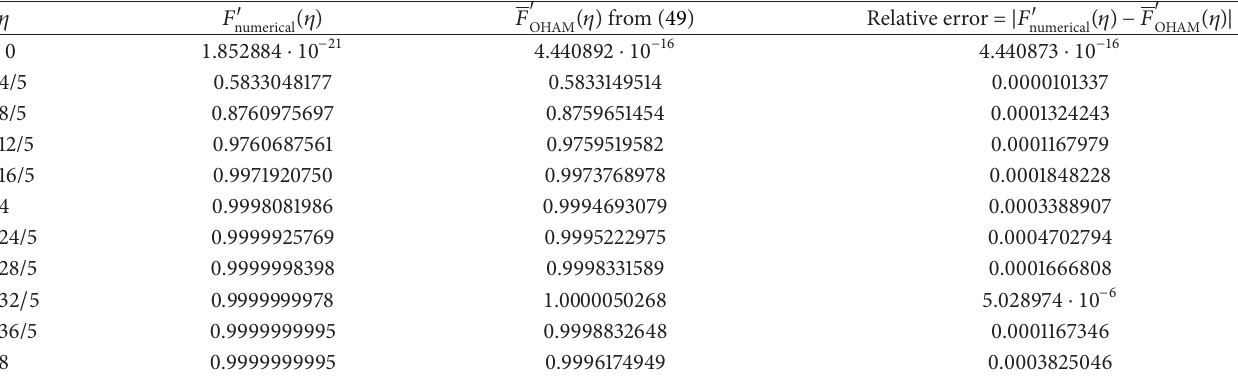
Table 2: Comparison between OHAM results for velocity 𝐹